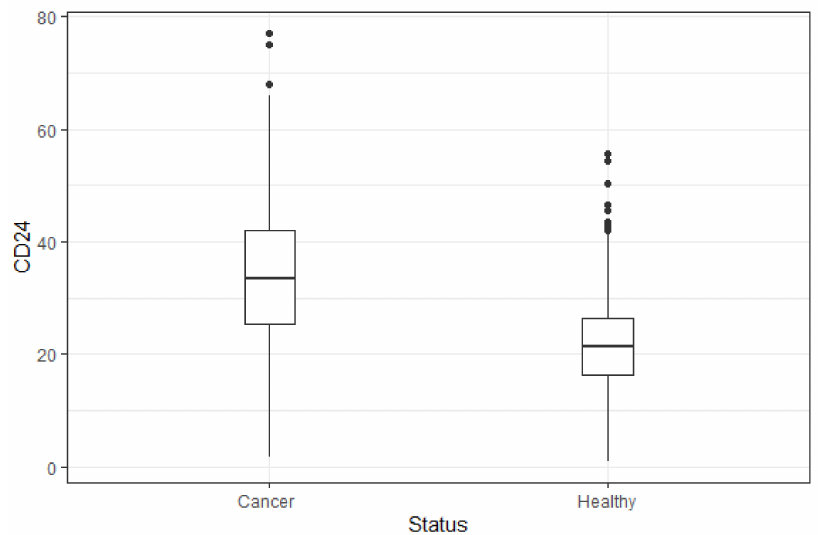
Figure 3. Box plot of the CD24 levels in healthy subjects versus cancer patients. Flow cytometry analysis showed levels of CD24/CD11b expression in PBLs obtained from study